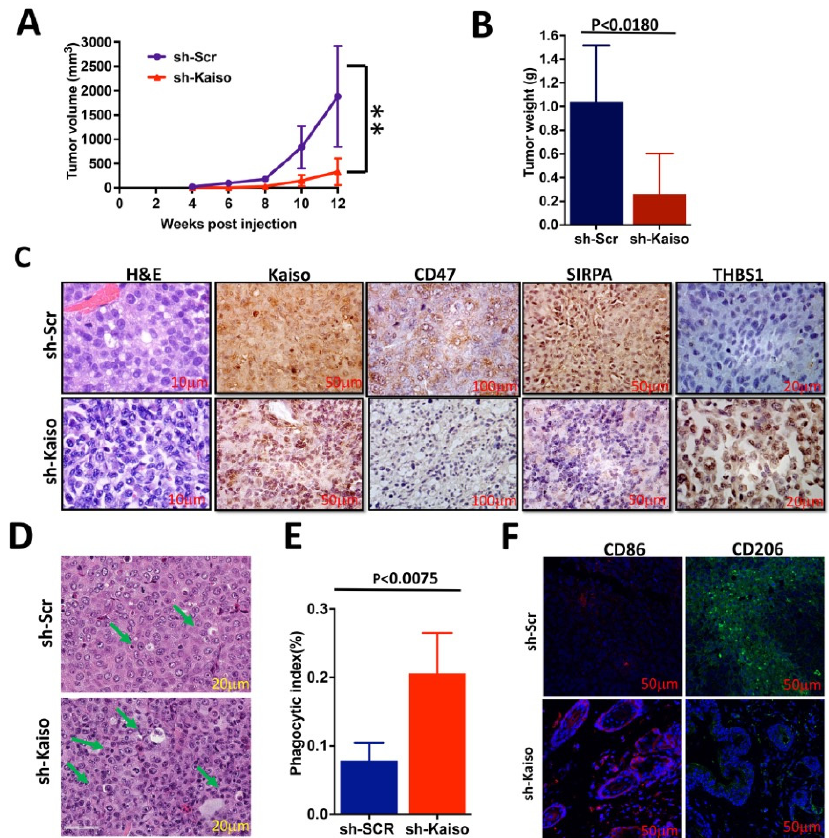
Figure 4. Kaiso depletion attenuates the growth of TNBC cells. ( A ) Kaiso-depleted MDA-MB-231 xenograft tumors (sh-Kaiso) showed delayed tumor onset (~4 weeks) and development compared to control MDA-MB-231 (sh-Scr) xenograft tumors, as demonstrated by time-course analysis of tumor volumes in nude mice. The statistical method used was the F test to compare variances between sh-Scr and sh-Kaiso groups (** statistically significant p < 0.01) ( B ) sh-Kaiso cells also developed smaller tumor sizes and reduced tumor weights as compared to sh-Scr cells. The statistical method used was the two-tailed paired t test. ( C ) IHC-stained images of xenograft tissues with Kaiso, CD47, and SIRPA antibodies showed a marked decrease in intensity but an increase in THBS1 in Kaiso-depleted (sh-Kaiso) tumor tissues. ( D , E ) Hematoxylin and eosin (H&E) staining showed significantly increased phagocytosis (green arrow showed phagocytosis) in sh-Kaiso xenograft tissues as compared to sh-Scr xenograft tissues. The statistical method used was the two-tailed paired t test. ( F ) Immunofluorescence images of xenograft tissues showed that sh-Kaiso tissues have a high intensity of CD86 and a low intensity of CD206, an M1 macrophage marker, whereas Kaiso control sh-Scr tissues had a low intensity of CD86 and a high intensity of CD206, an M2 macrophage